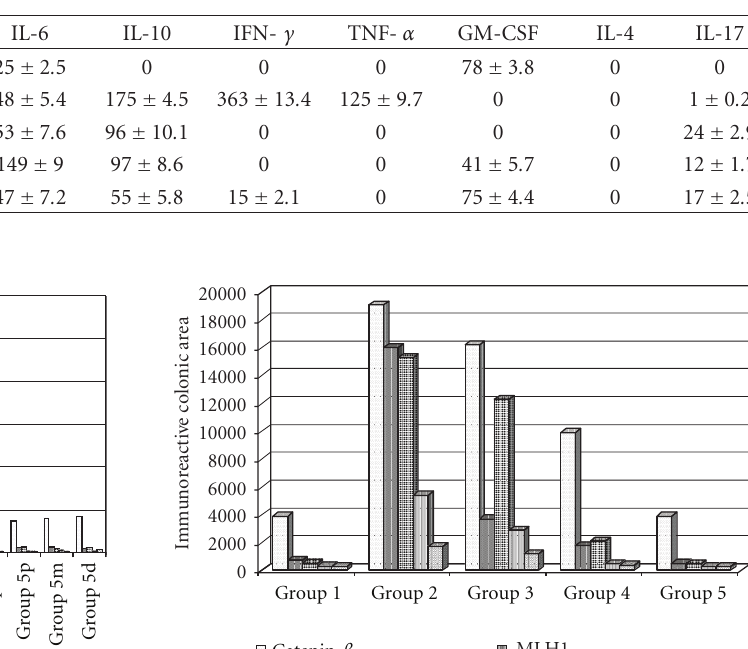
Table 2: Levels of IL-1 α (pg/mL), IL-2 (pg/mL), IL-5 (pg/mL) IL-6 (pg/mL), IL-10 (pg/mL), IFN- γ (pg/mL), TNF- α (pg/mL), GM-CSF (pg/mL), IL-4 (pg/mL) and IL-17 (pg/mL) in mice serum samples. Data are expressed as mean ± standard deviation.